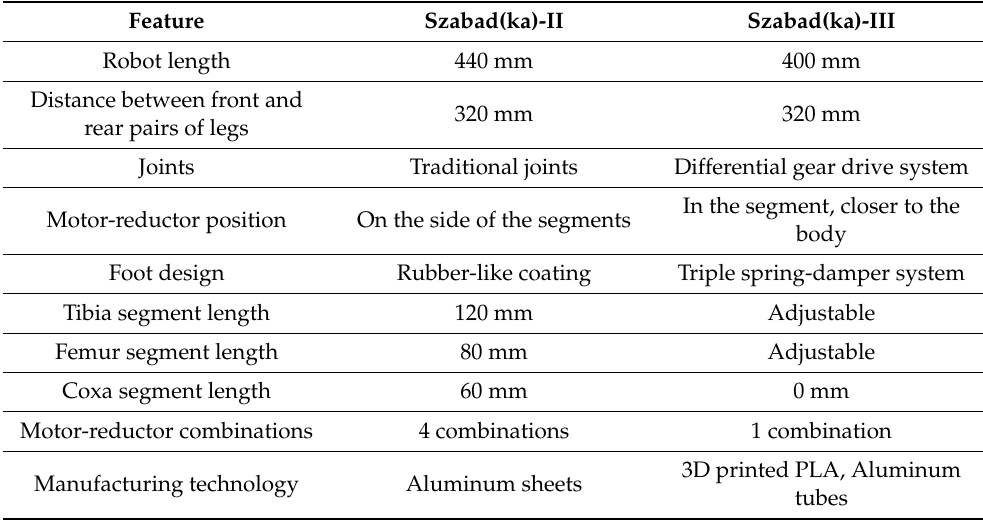
Table 1. Mechanical features of Szabad(ka)-III in comparison with Szabad(ka) II.